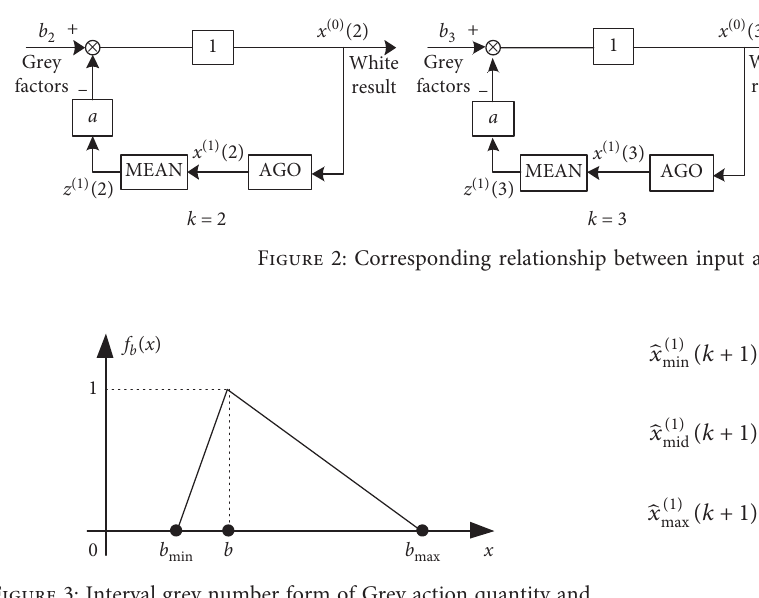
Figure 3: Interval grey number form of Grey action quantity and its possibility